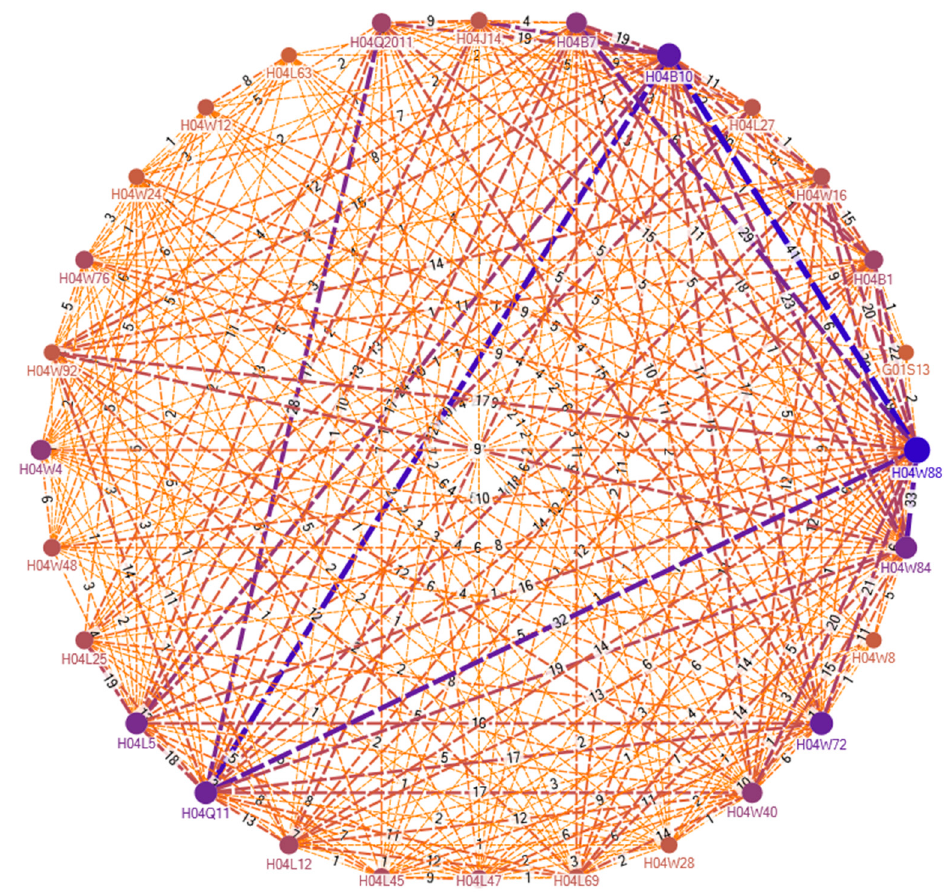
Figure 1. Level-4 CPC network of 5G optical networks. Note: The size of a node indicates the number of nodes it is connected to. The thickness of an arc indicates the strength of the connection, namely the number of patents shared. To keep the figure succinct, only nodes that were connected to more than 25 other nodes were retained. Table 4. Top five CPC codes of 5G optical networks.